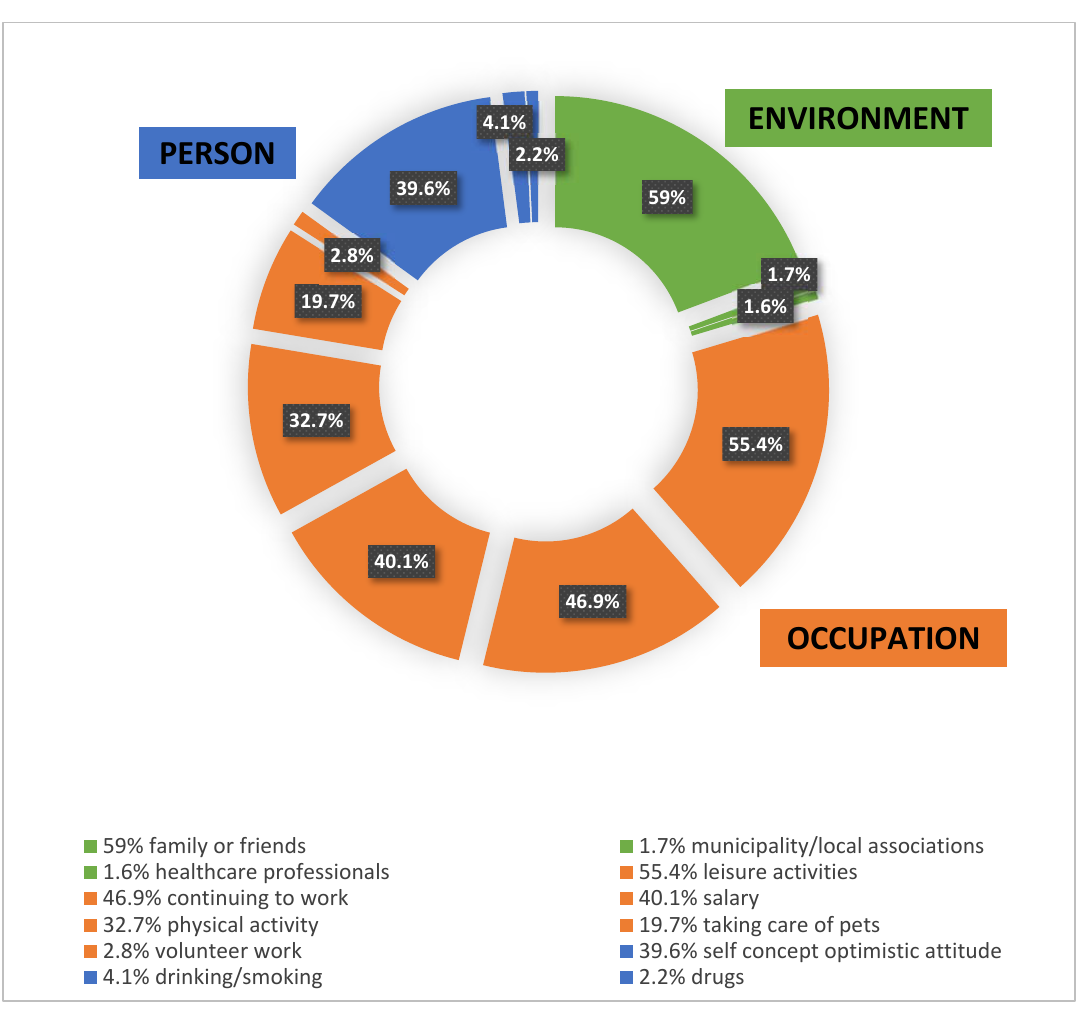
Figure 2. Percentages of participants who reported the kinds of factors (according to the Person, Environment, Occupation model) that helped them to deal with the first lockdown. Figure 3 describes the local support services used by 476 participants. Grocery deliv- ery and hotlines providing information and mental health support were the most used, as reported by 18.9% and 6.6% of participants, respectively.